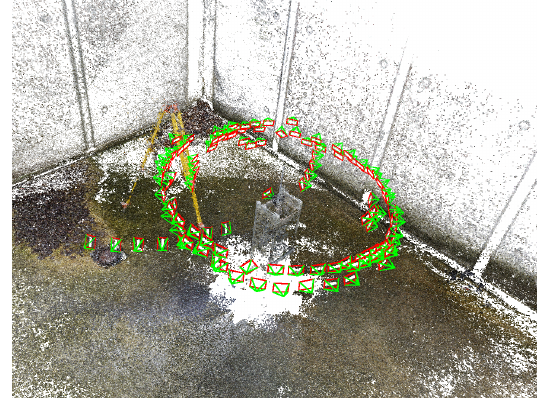
Figure 4: Geometry of acquisition for optical center calibration